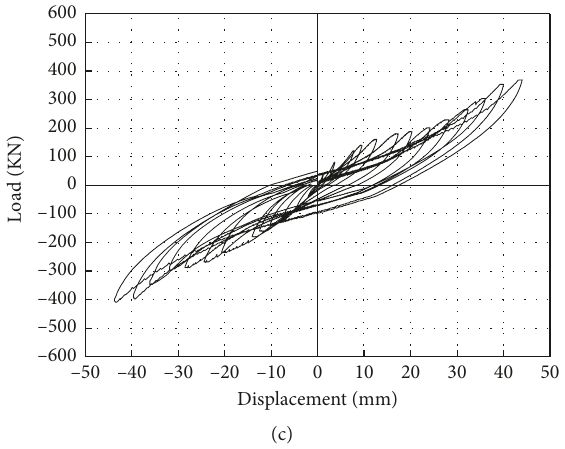
Figure 10: Hysteresis curve: (a) UWF, (b) TMWF, and (c) PDWF.